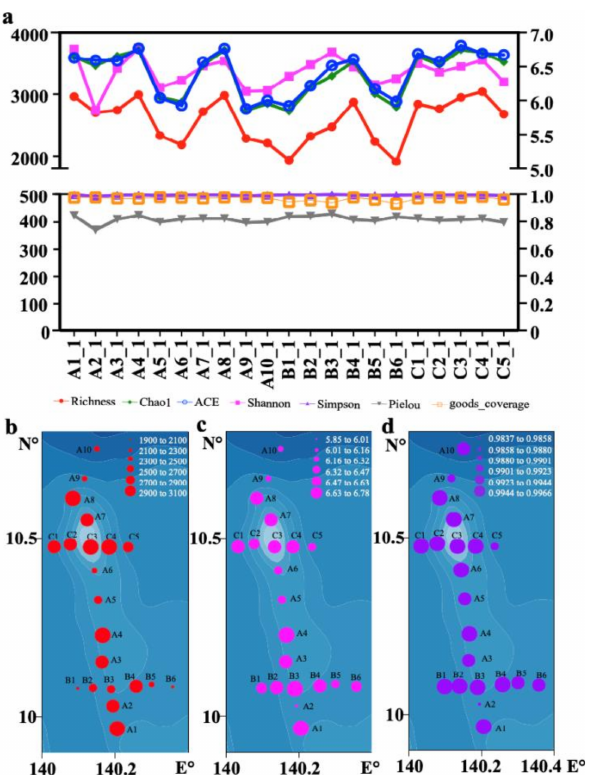
Figure 4. Alpha diversity of surface samples from the Western Pacific seamount regions. ( a ) The alpha diversity of surface samples. The data are all phytoplankton ASVs; ( b ) Richness, ( c ) Shannon’s diversity, and ( d ) Simpson’s diversity of surface samples in the Western Pacific seamount regions.